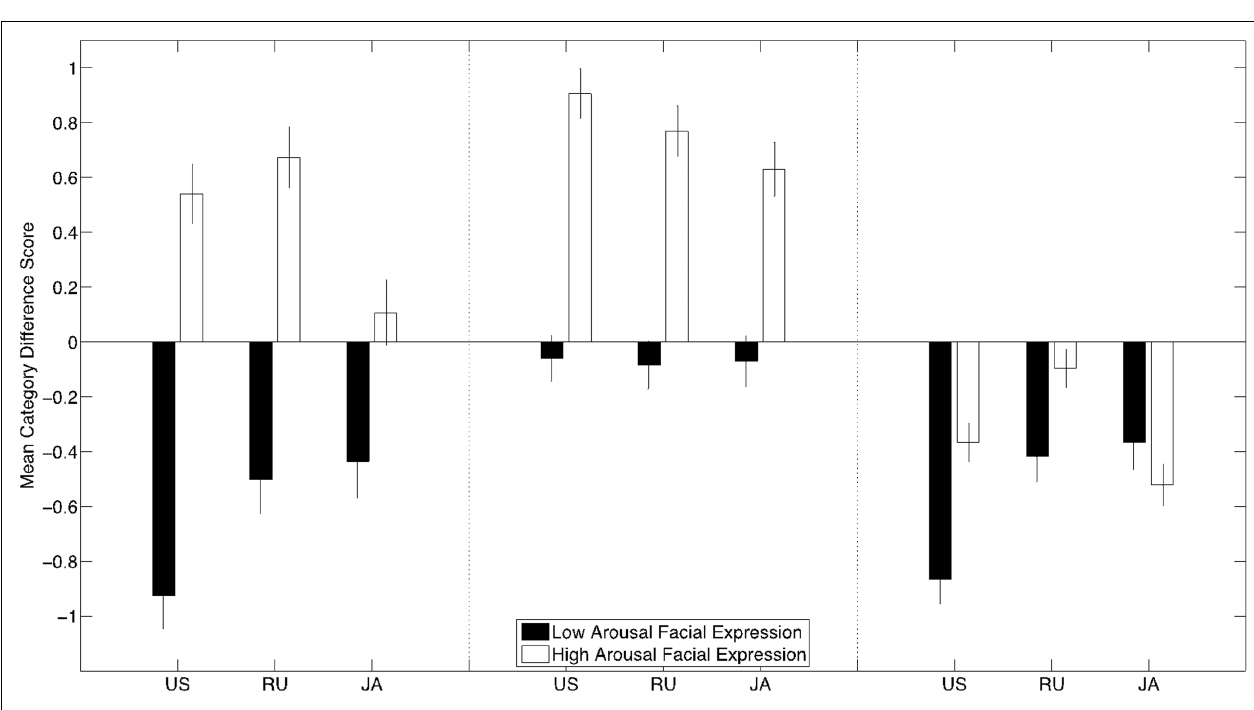
FIGUREA3 | Cultural differences in mean category difference scores based on ipsatized data as a function of arousal intensity of facial expressions. Significant cultural differences obtained from this additional analysis confirm those reported in the main paper and are listed in detail in TableA13 above.